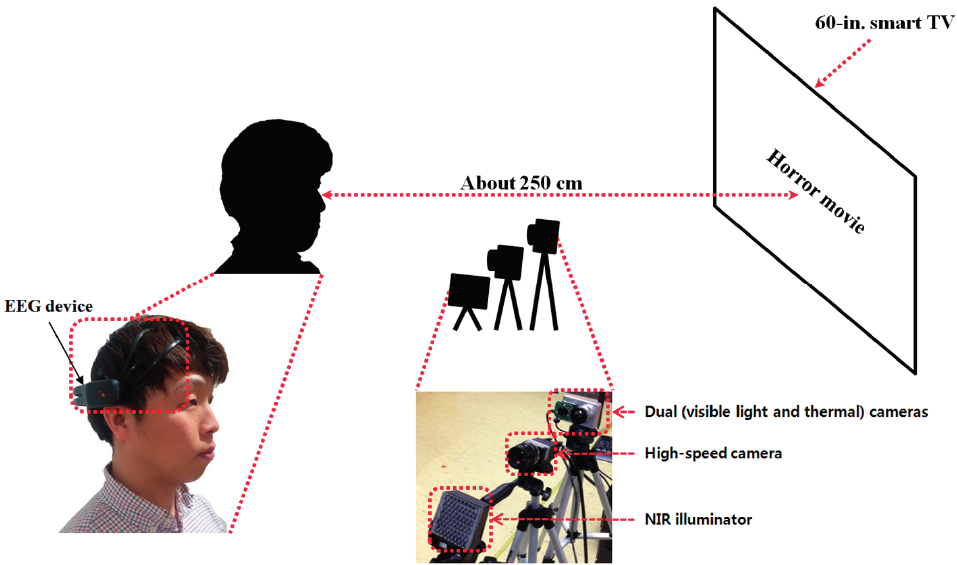
Figure 2. Proposed system for evaluating